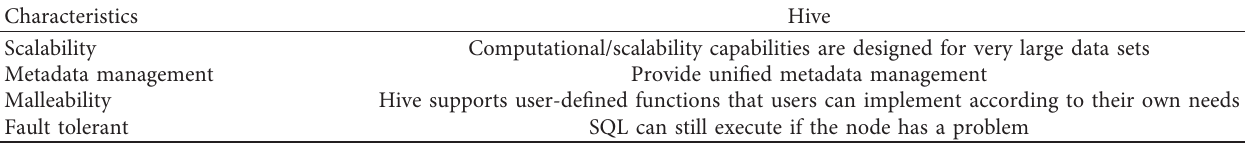
Table 4: The characteristics of